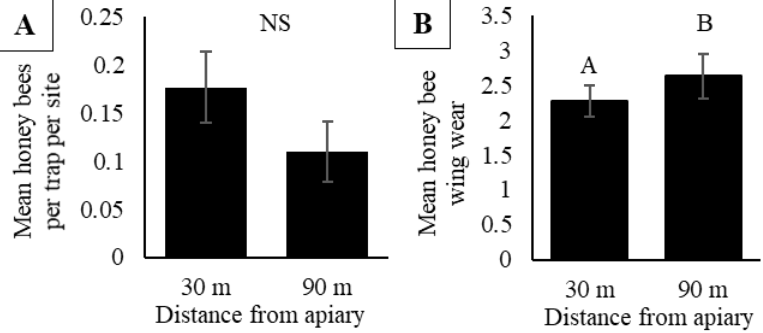
Figure 5. ( A ) Mean honey bee activity-density (bees per trap per site) in pan traps in soybean fields with increasing distance from the apiary (30m or 90m) in central Iowa during 2017 and 2018. ( B ) Mean honey bee wing wear of honey bees collected in pan traps placed 30 m and 90 m from the apiary. Results based on a mixed model analysis of variance. Data represent mean ± one standard error of the mean. Letters signify significant differences ( p < 0.05).